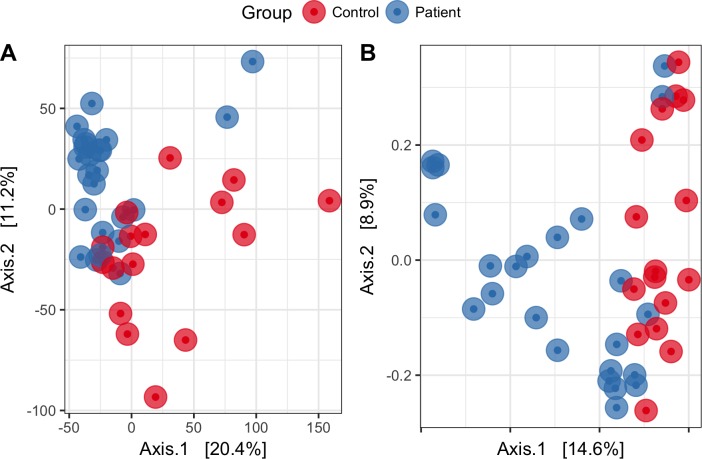
Principal coordinates analysis (PCoA) based on Bray Curtis distance matrix (A) and Euclidean distance matrix (B) show the separation of gut microbiomes between GSD patients and controls. Each point represents a microbial community from one subject; colours indicate the treatment.